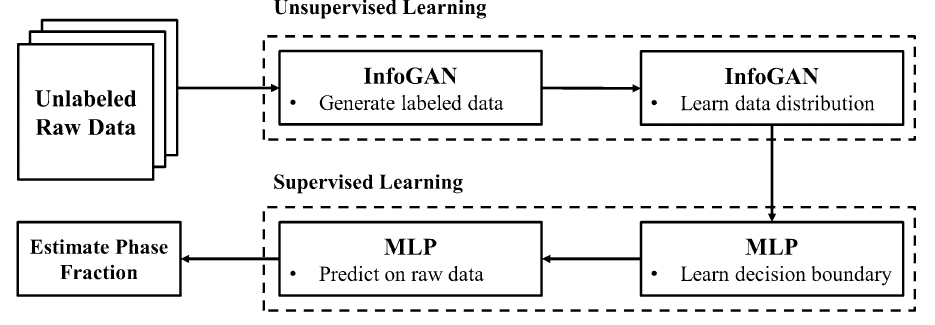
Figure 1. The workflow of the proposed